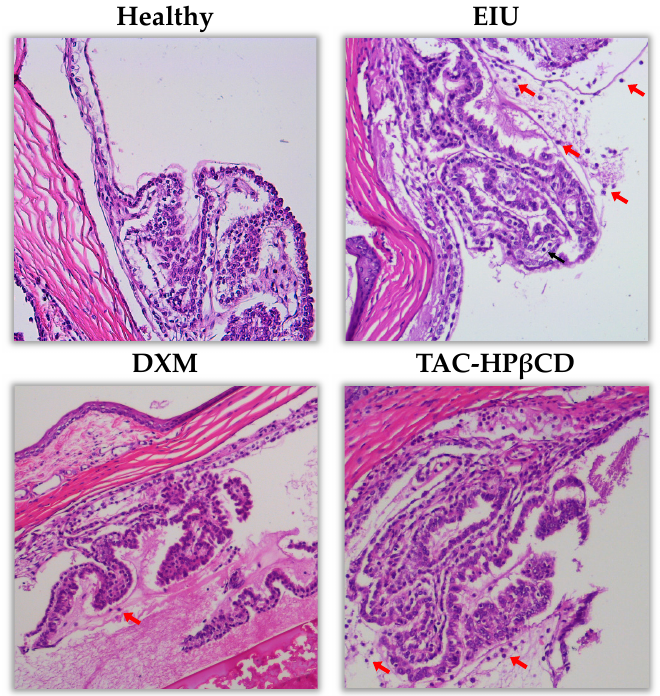
Figure 5. Representative hematoxylin-eosin staining showing infiltrated leucocytes (marked with arrows) in retina and ciliary processes of healthy, EIU, DXM and TAC-HP β CD groups. The histology study was carried out 24 h after LPS injection.